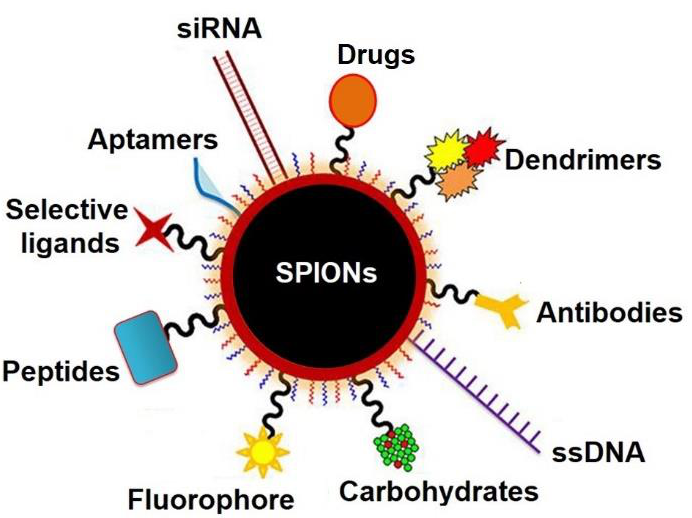
Figure 2. Representation of possible MNP functionalizers able to confer the theranostic identity.